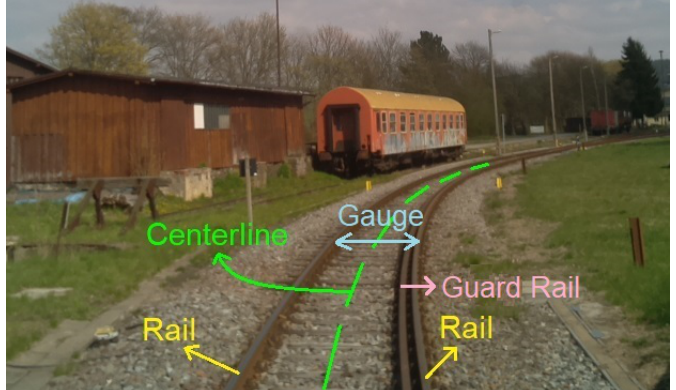
Figure 2. Terms used in the description of the algorithm. Image source: Camera mounted on RailDriVE. The center line of the tracks were extracted from the point cloud using the following steps: 1.